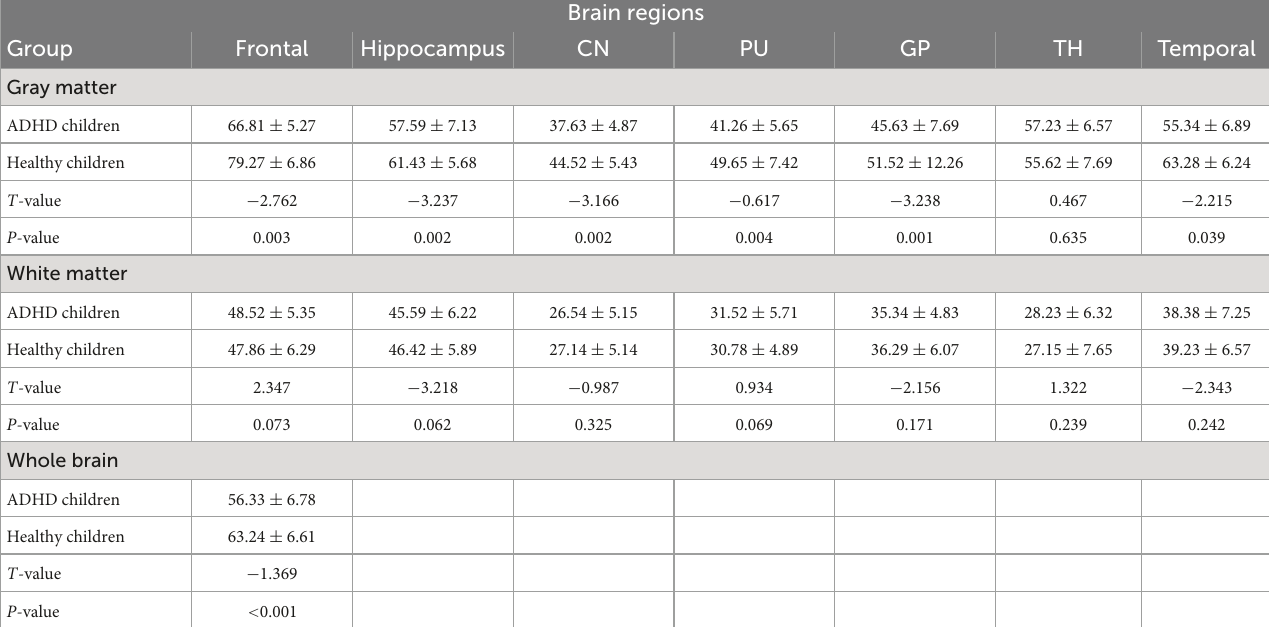
TABLE 2 Comparison of the CBF value between the ADHD and healthy children groups (mL/100 g ·